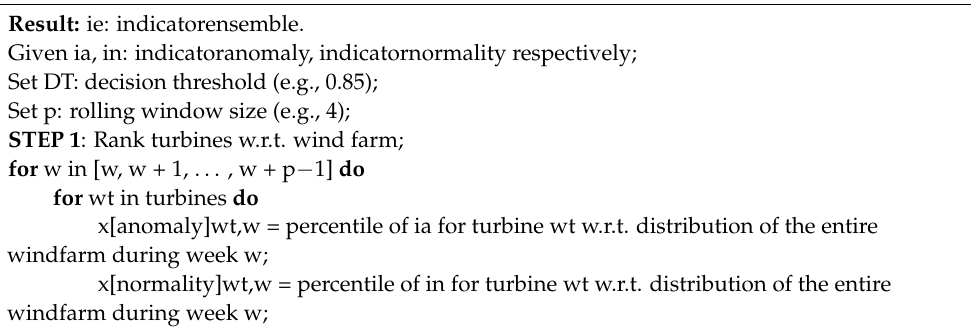
Algorithm 2 Computation of the ensemble